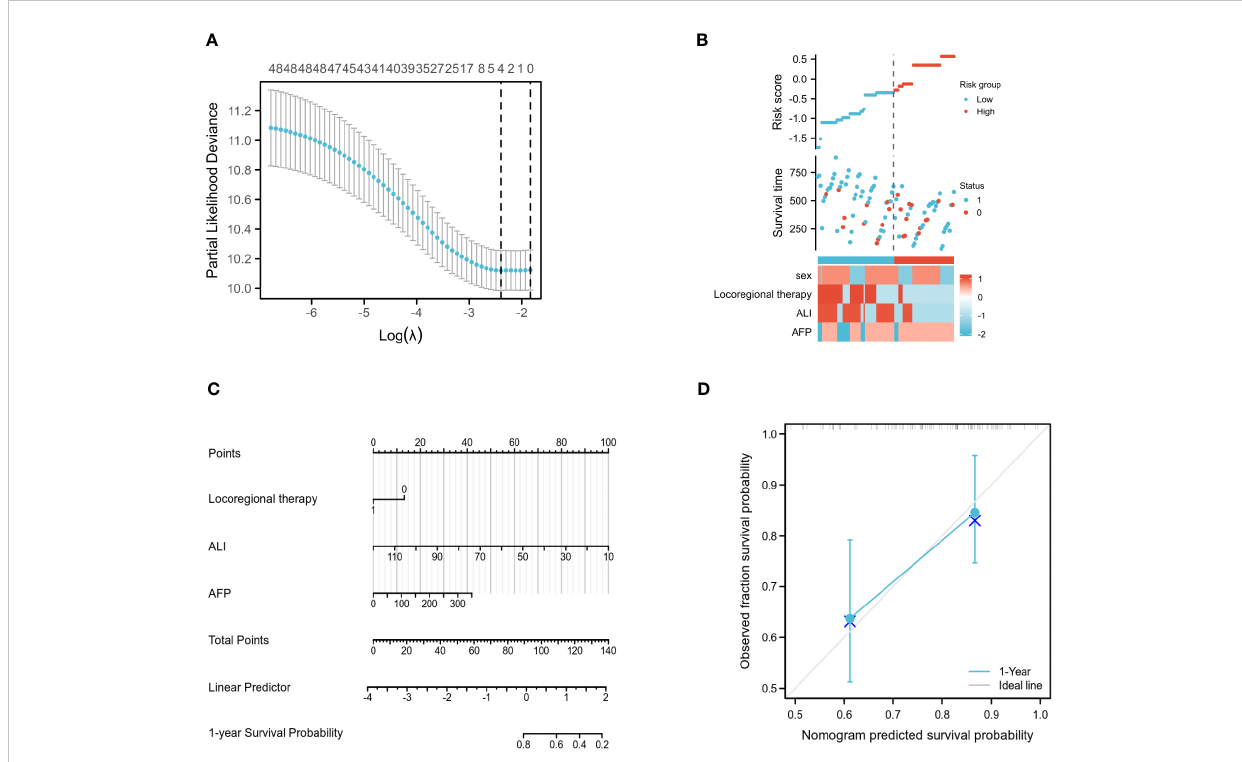
FIGURE 3 Training set model construction. (A) LASSO binary logistic regression models were used for variable selection. (B) Models screened for risk factor visualization. (C) Nomogram for predicting OS in patients with advanced hepatocellular carcinoma based on ALI and independent prognostic factors. (D) Nomogram calibration chart for 1-year OS prediction in advanced liver cancer